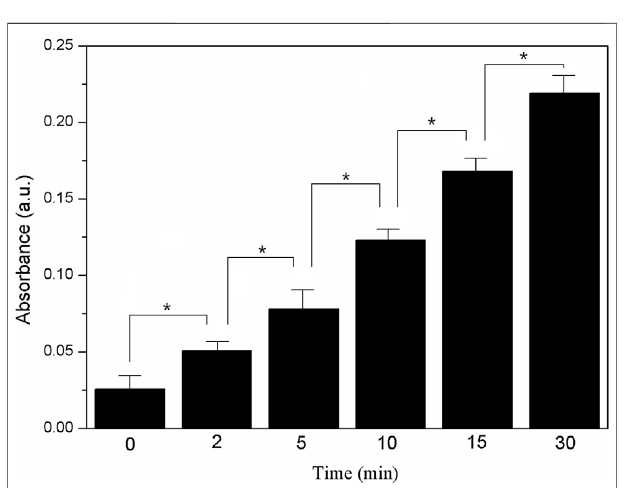
FIGURE 12 | Concentration of H 2 O 2 after treated with AA, AA + LY@ ZnO, AA + LY, and AA + ZnO.